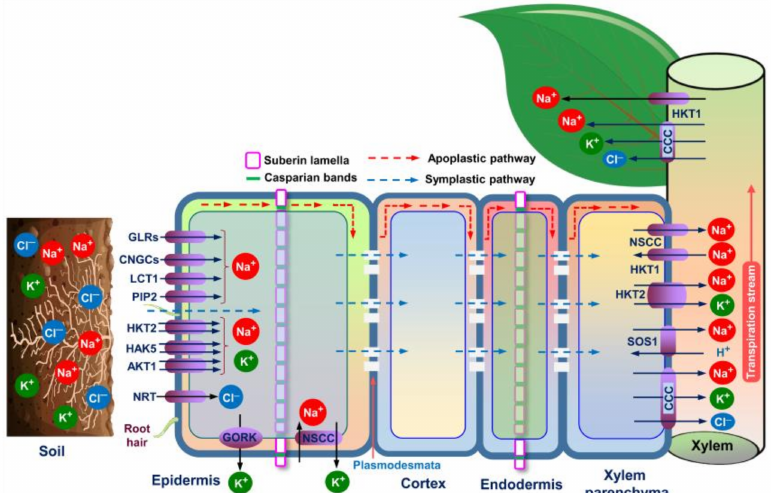
Figure 2. Putative salt uptake and accumulation mechanisms in an ideal halophyte plant (modified from Zhao et al. [11], Arif et al. [34], and Arbelet-Bonnin et al. [72]. Na + is transported from soils to/within plant root cells via two major pathways: symplastic and apoplastic. The major transporters/channels embedded in the root epidermis for up-taking Na + are GLRs, CNGCs, LCT1, PIP2, HKT2, HAK5, and AKT1. In the presence of Na + , K + is competitively uptaken via HKT2, HAK5, and AKT1. The entrance of Cl − into the root cells is mediated by separate transporters, including NRT. NSCC and GORK channels, on the other hand, are involved in salinity-induced K + exclusion from the root epidermis. Apoplastic barriers, consisting of Casparian bands and suberin lamellae in the epidermis and endodermis of the roots, can block and/or limit the bypass flow of Na + and other solutes moving to the aboveground parts. Passive Na + entry into the xylem is facilitated by NSCCs, while cotransporters like SOS1, CCC, and HKT2 are required for active loading of Na + into the xylem. Na + can return to xylem parenchyma using HKT1. The xylem-loaded Na + , K + and Cl − can be transported up through the transpiration stream, and subsequently enter into the aboveground organs via CCC and HKT1. Abbreviations: AKT1, Arabidopsis K + transporter 1 (a shaker-type K + channel); CCC, cation-chloride cotransporter; CNGC, cyclic nucleotide-gated channel; GORK, gated outwardly rectifying K + channel; GLR, glutamate receptor-like channel; HKT, high-affinity potassium transporter; HAK, high-affinity potassium uptake transporter; LCT, low-affinity cation transporter; NRT, nitrate transporter; NSCC, non-selective cation channel; PIP2, plasma membrane intrinsic protein; SOS1, salt overly sensitive